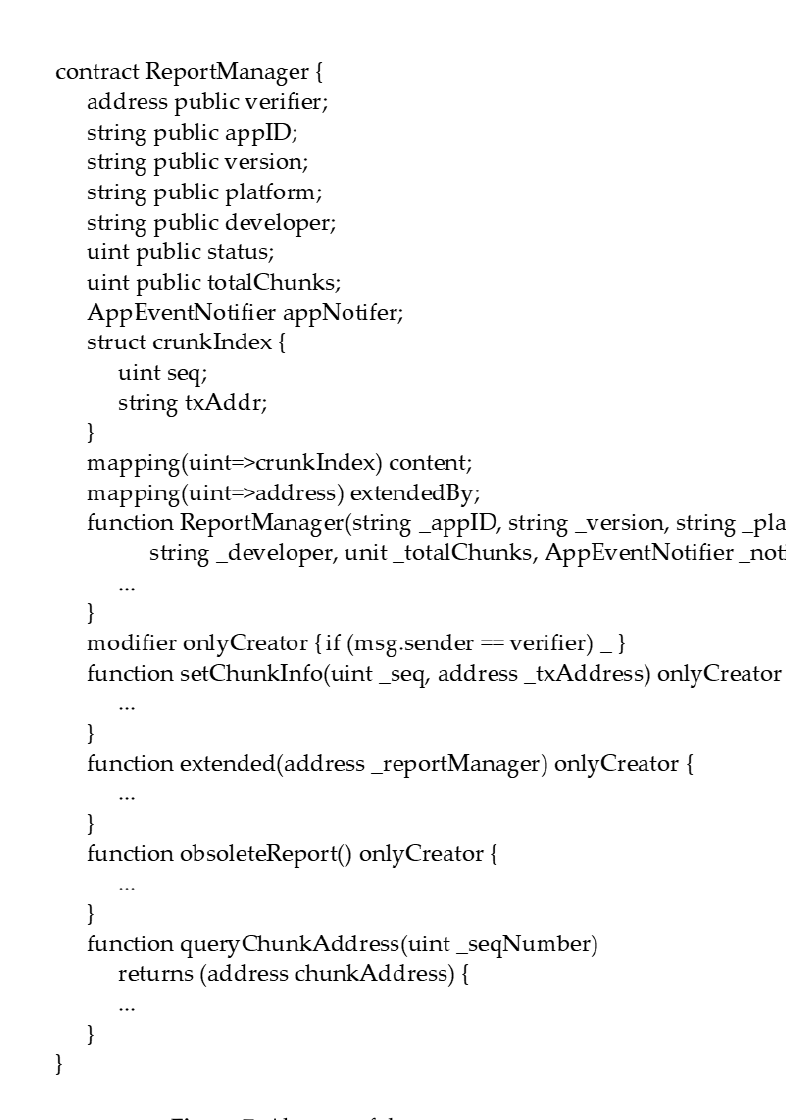
Figure 7. Abstract of the report manager smart contract.